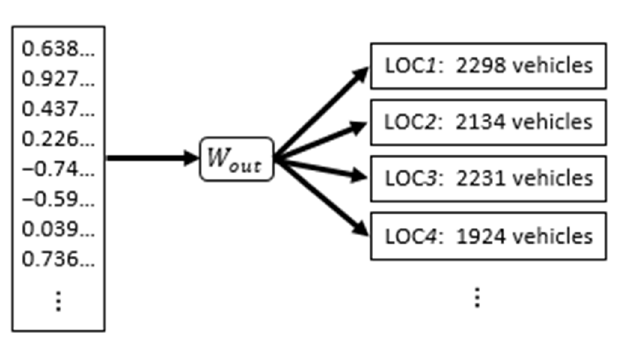
Figure 5. Output layer information reshaping process from the LSTM final vector representation to the explicit traffic volume distribution across the different reference locations.